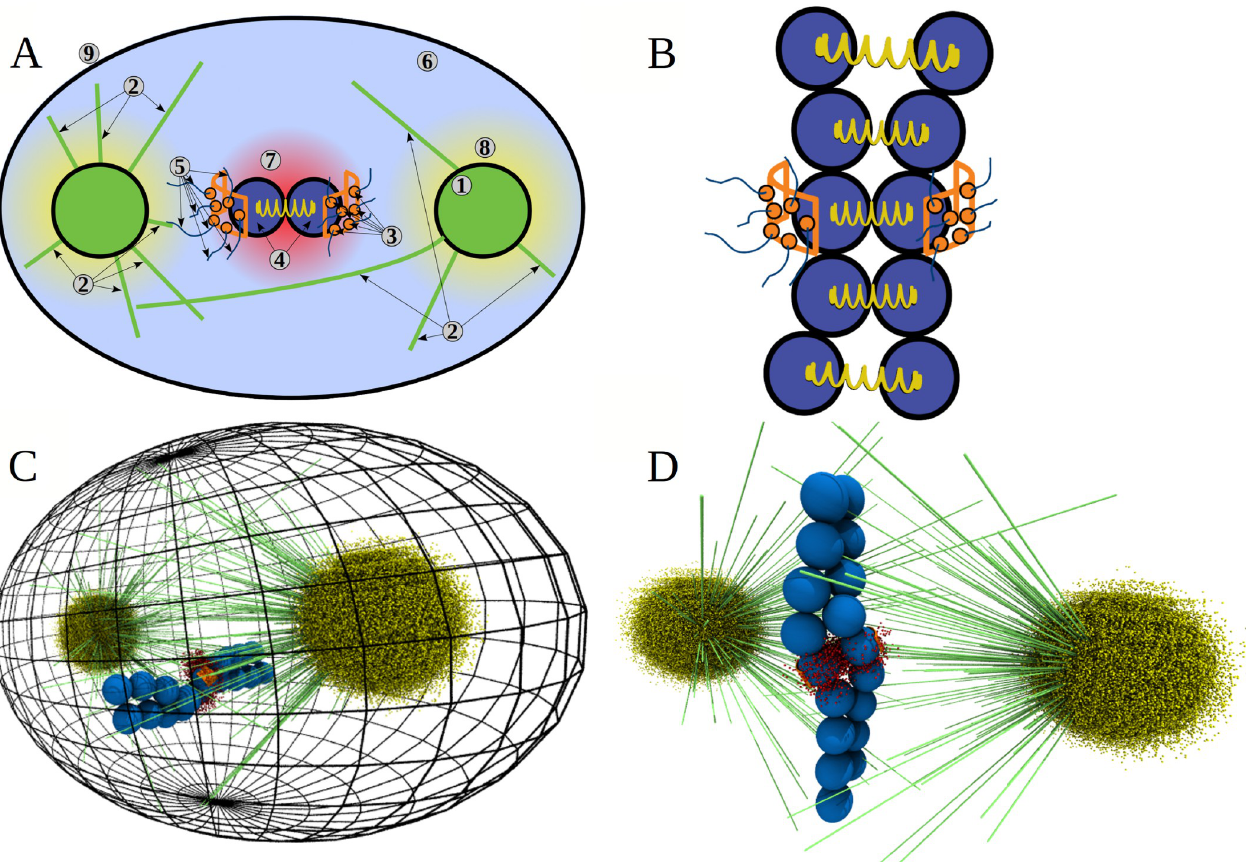
Fig 1. Components of Stochastic Reaction-Diffusion-Dynamics model implemented in CellDynaMo package. A) Schematic of the Stochastic Reaction- Diffusion-Dynamics model. 1) Spherical centrosomes (CS) with the microtubules’ (MTs) plus-ends on the surface (400-nm radius, 750 MTs per centrosome); 2) Microtubules (MTs) described by 12.0-nm spherical beads, each representing ~40 4.0-nm αβ -tubulin dimers; 3) Kinetochores’ corona regions (on spherical surface) in which the complexes of Ndc80 bound to MTs with their kinetochore-associated domains, spherical 8.0-nm beads, are labelled; 4) Kinetochore pairs (KTs) and sister Chromatids (Chs) represented by spherical beads with 362.5-nm radius (number of beads depends on the size of the chromatid arms, see B ); 5) Ndc80 protein complexes with KT via the spherical kinetochore binding domains and the labelled 60.0-nm triple-helical coiled coil domain modeled as a harmonic spring connected to corona surface from one side and to MT plus-end from other side; 6) Blue space is Phosphatase (enzyme performing dephosphorylation of Ndc80), which is uniformly distributed in the interior space of the cell; 7) Aurora B kinase (AB; enzyme performing phosphorylation of Ndc80) is described by the spherical gradient of its concentration with the central maximum in the space between the kinetochores (red cloud); 8) Aurora A kinase (AA; enzyme performing phosphorylation of Ndc80) is described by the spherical gradient of its concentration with the twin maxima centered on the two centrosomes (yellow cloud). In the model, components 1–4 are described using the Langevin Dynamics in the Brownian diffusion limit (Table 1), whereas components 5–8 are modeled using the stochastic reaction-diffusion master equation (Table 2). 9) Cellular membrane is modeled parametrically as a smooth repulsive potential for all cell components. B) More detailed view of metaphase chromosomes (CHs) comprised of identical paired sister Chromatids (Chs). The entire length of each chromatid is represented by connected beads and neighboring beads on the adjacent sister chromatids are connected by a spring. C) Snapshot in 3D of a single trajectory from the CellDynaMo simulation that shows all the components, including cell membrane (black grid). D) Closer cell interior view of the Stochastic Reaction-Diffusion-Dynamics model showing all components: MTs (lime tubes), KTs and Chs (blue beads), corona with Ndc80 seeds (orange wall sections). CS pair are hidden behind point clouds of AA kinase (yellow). AB kinase (red point cloud) is located between KTs.